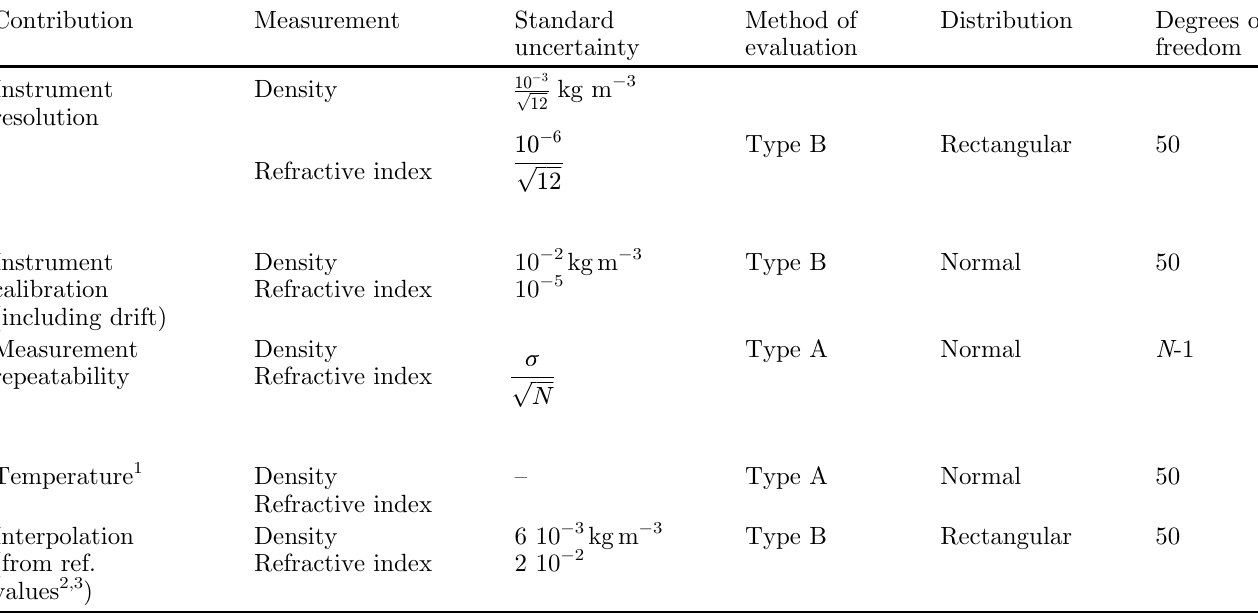
Table 1. Uncertainty budget of the absolute salinity results, S S ( n ), measurements at 20 ° A